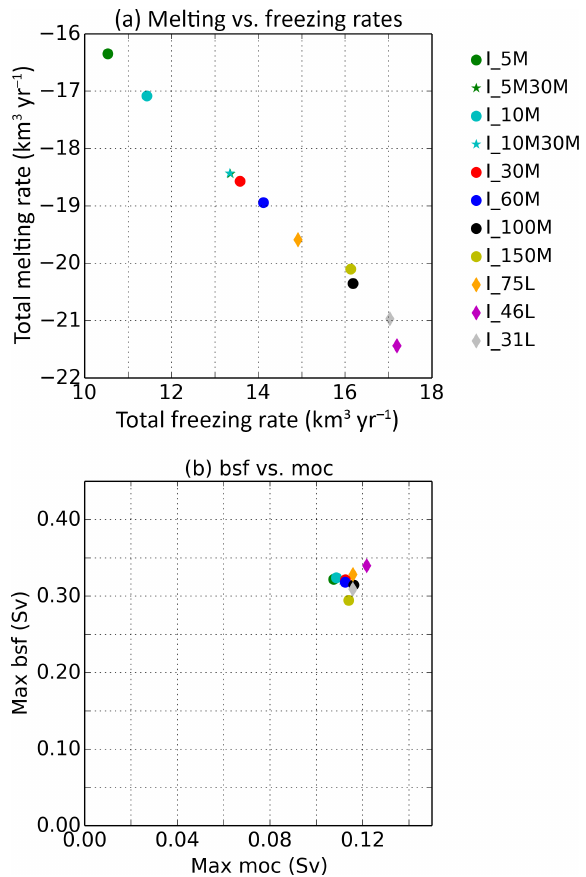
Figure 3. (a) Total melting rate versus total freezing rate, and (b) meridional overturning circulation versus barotropic stream function (bsf) for all the ISOMIP sensitivity experiments (I_5M, I_10M, I_30M, I_60M, I_100M, I_150M, I_31L, I_46L and I_75L). The simulations I_XXM are with constant vertical resolu- tions of XXm and a H TBL of 30m, the simulations I_XXMYYM are with constant vertical resolution of XXm and a H TBL of YYm, Finally, the simulations I_XXL are with variable vertical resolution. Details are given in Table